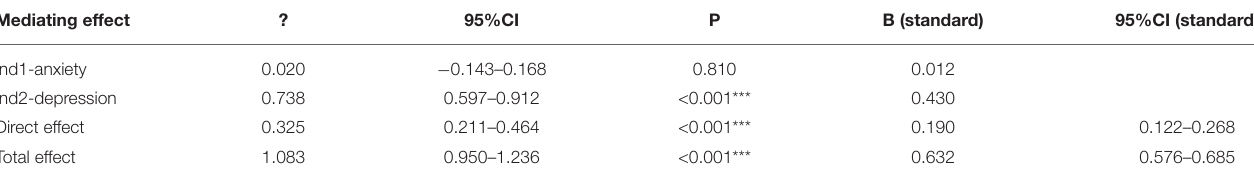
TABLE 5 | Mediating effect, direct effect and total effect